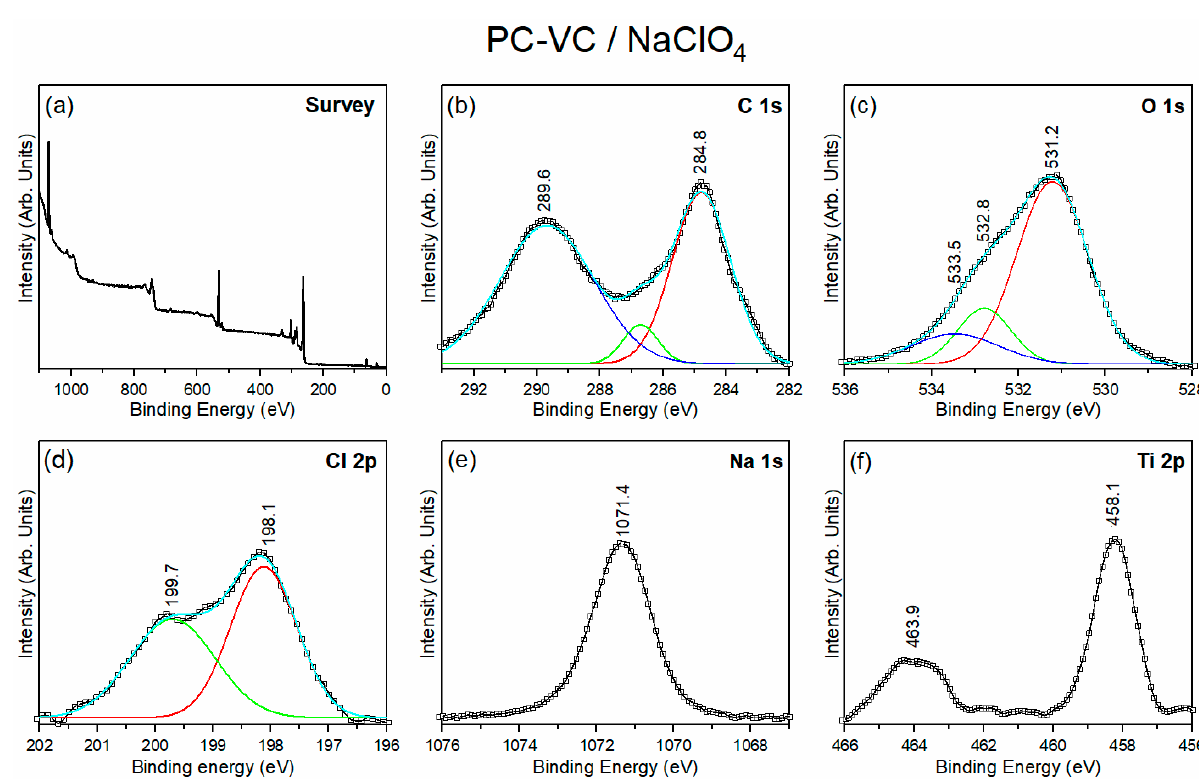
Figure 8. High-resolution XPS spectra of TiO 2 nanosheet electrodes after 30 cycles in PC-VC / NaClO 4 electrolyte solution for ( a ) survey, ( b ) C 1s, ( c ) O 1s, ( d ) Cl 2p, ( e ) Na 1s, ( f ) Ti 2p.